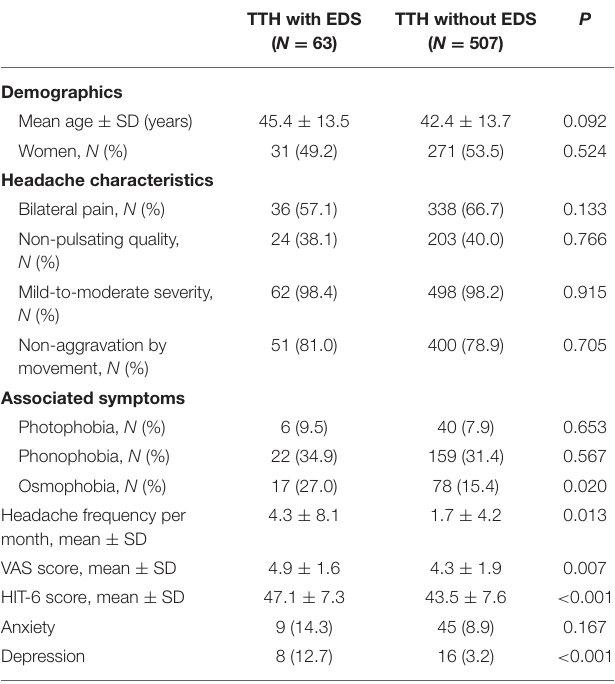
TABLE 2 | Demographics and clinical presentation of individuals with tension-type headache (TTH) according to the presence of excessive daytime sleepiness (EDS). TTH with EDS TTH without EDS ( N = 63) ( N =